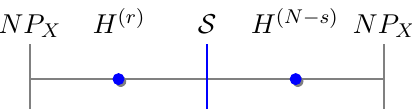
(cid:0) (cid:1) S 3 with two defects corresponds to the insertion of ’t T